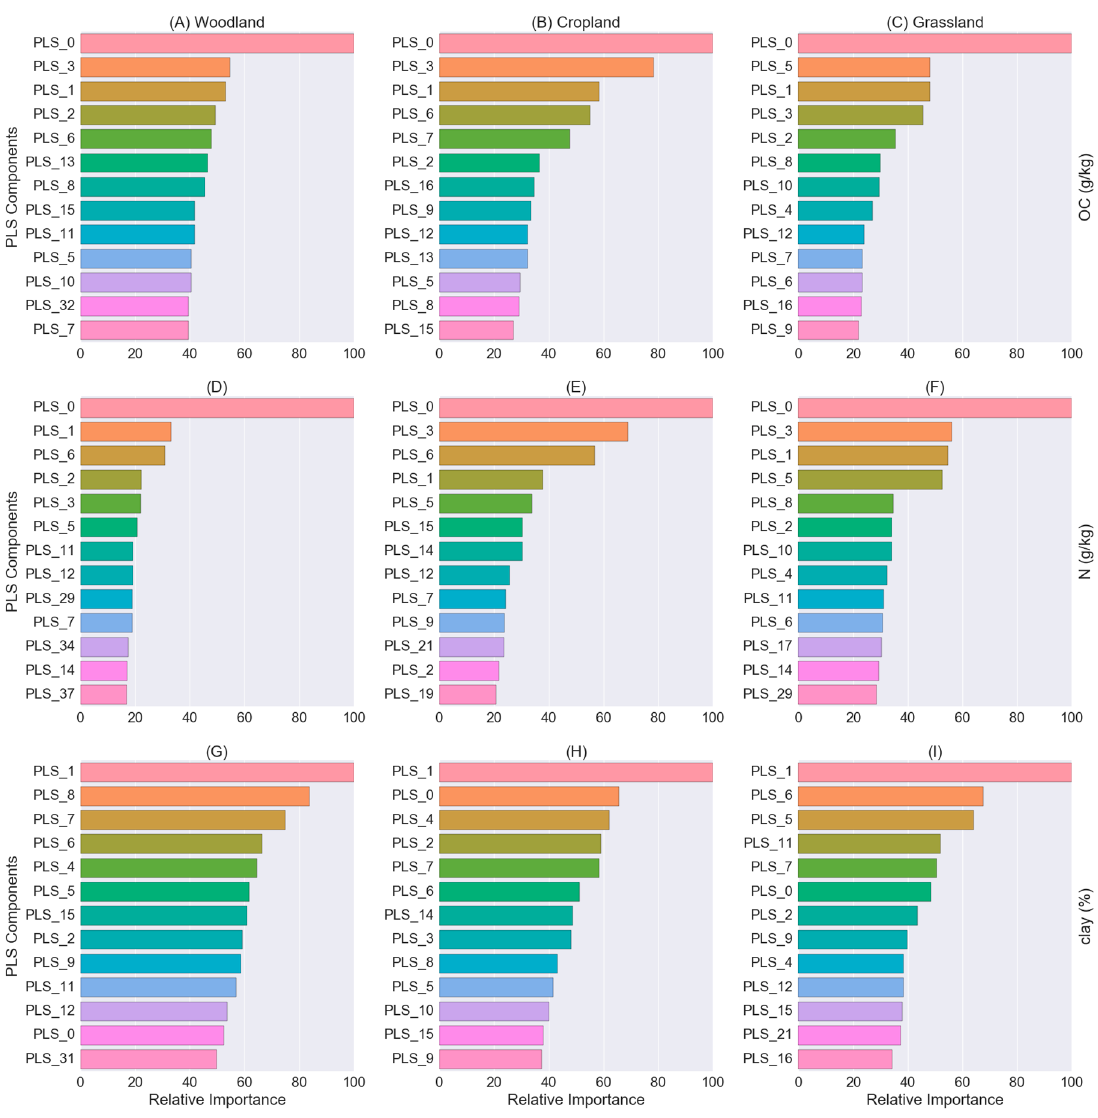
Figure 10. The top 13 relative important variables (PLS components) derived from PLS-GBDT. ( A – C ) are relative important variables derived from OC models for woodland, cropland, and grassland soils, and ( D – F ) are relative important variables derived from N models, and ( G – I ) are relative important variables derived from clay models.